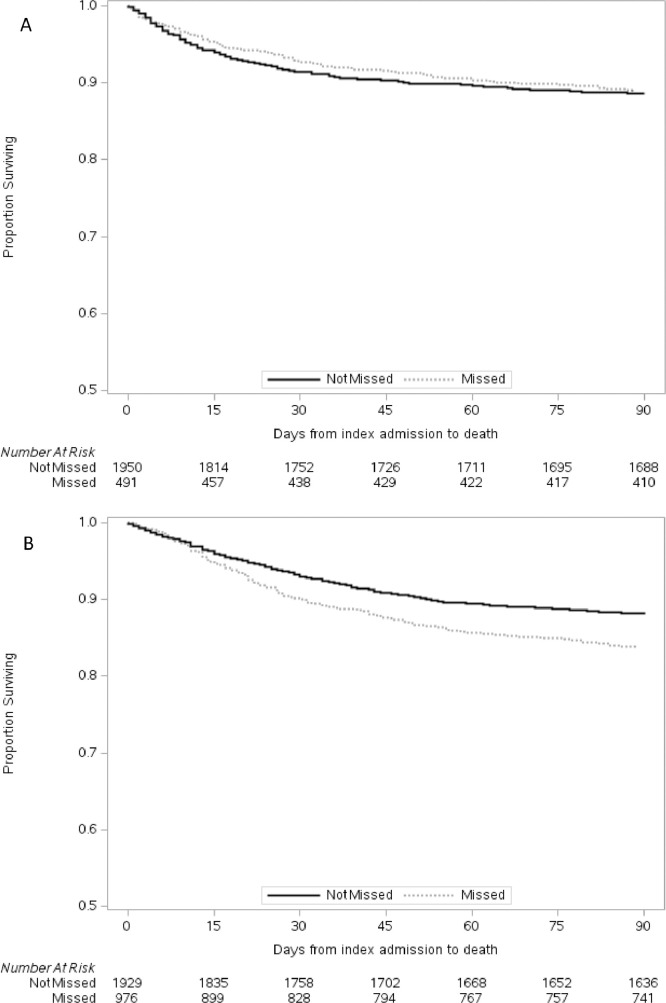
Cox proportional hazards curves comparing time from index admission to death by potential missed diagnosis of cryptococcal disease for (a) persons living with HIV and (b) HIV-negative patients. Patients with a potential missed opportunity for diagnosis of Cryptococcus have a higher mortality amongst those that are HIV-negative, but not those that are HIV positive.